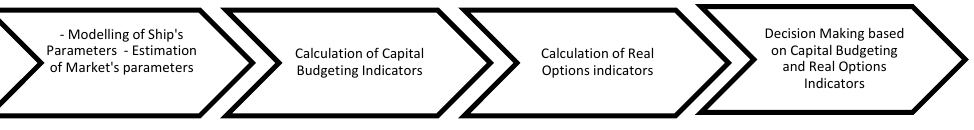
Figure 2. Investment evaluation of WHRS of the study.